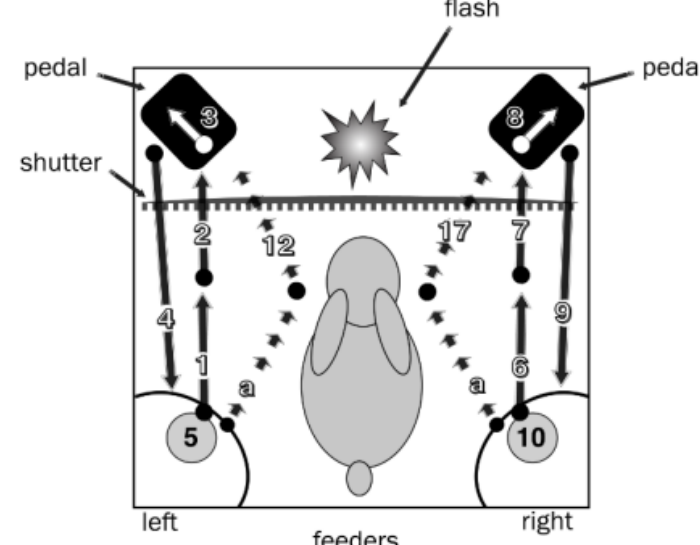
Figure 1. The experimental cage and all studied behavioral acts: 1 - turning a head from the left feeder to the left pedal; 2 - approaching the left pedal; 3 - pressing the left pedal; 4 - approaching the left feeder, 5 - food intake from the left feeder, 6 - turning a head from the right feeder to the right pedal; 7 - approaching the right pedal; 8 - pressing the right pedal; 9 - approaching the right feeder, 10 - food intake from the right feeder, a – the delay period, 12 - approaching the left pedal after the delay period, 17 - approaching the right pedal after the delay